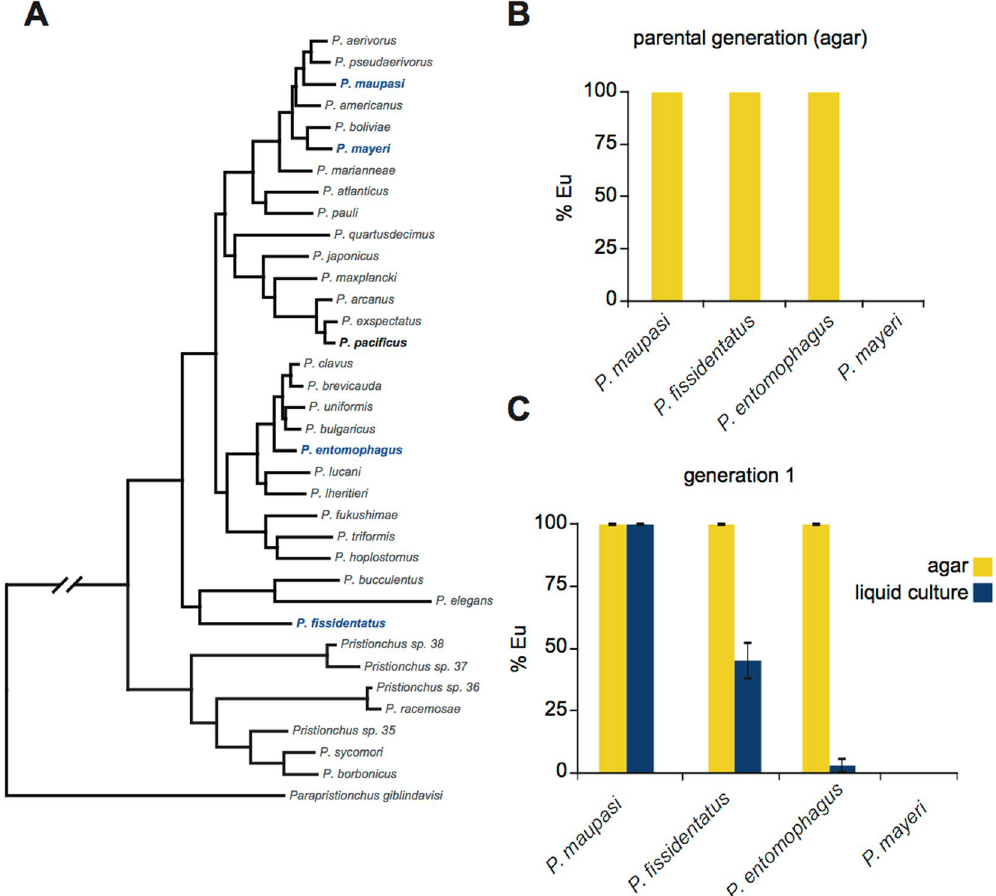
Figure 5. Macro-evolutionary view of liquid culture environmental influence. ( A ) Phylogeny of Pristionchus species 70 highlighting P . pacificus (bold), P . fissidentatus , P . mayeri , and P . entomophagus (blue). ( B ) Mouth- form ratio of parental generations ( n = 3) of indicated species on NGM-agar after three consecutive healthy generations on OP50. ( C ) Mouth-form ratios of indicated species in either NGM-agar or liquid culture/S- medium ( n = 3), error bars represent